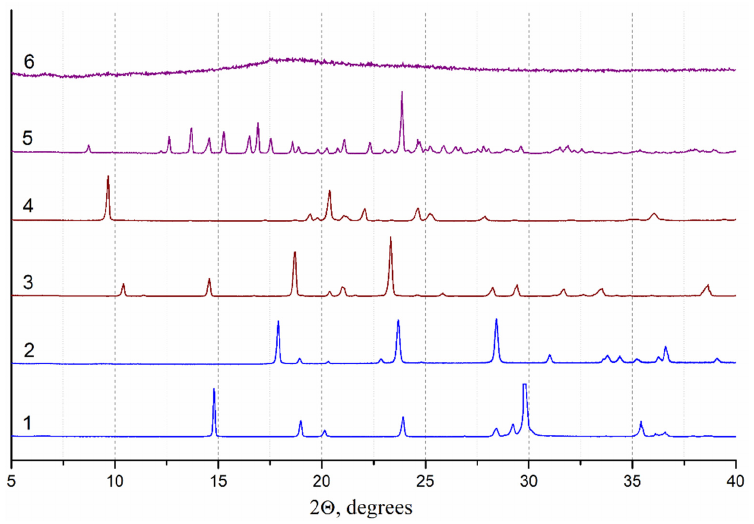
Figure 4. X-ray powder diffraction patterns: (1) starting α -glycine; (3) starting β -mannitol, (5) starting trehalose dihydrate. The samples obtained under identical conditions as formulations: β -glycine (2), mannitol (4), and trehalose (6).